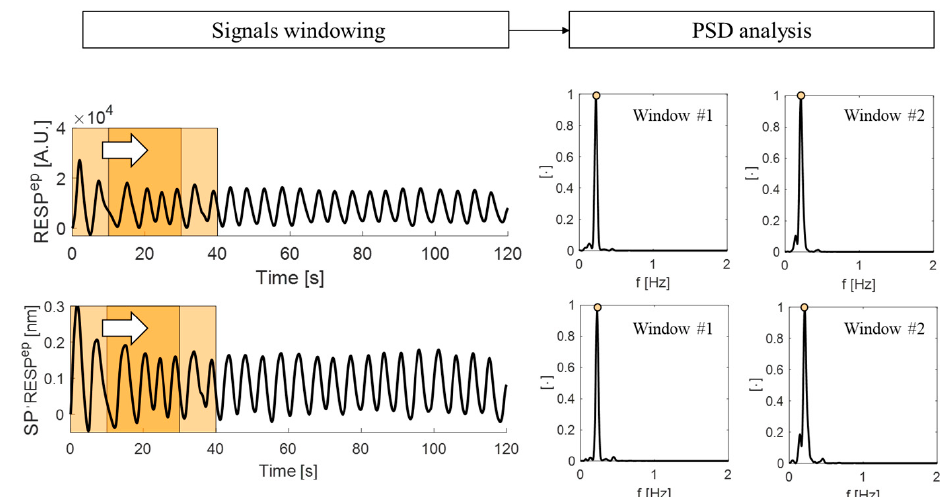
Figure 10. The signals windowing performed over the respiratory signals (reference trace RESP ep and SP RESP ep ) recorded during eupnea in supine position. Two consecutive 30 s windows with an overlap of 10 s are highlighted (orange squares). For each window, the PSD spectrum is computed. Therefore, the RR and HR values estimated by the smart patch and the reference system were obtained from the PSD dominant frequency and expressed in apm and bpm, respectively. The windowed values of RR and HR of a subject (i.e., S1) in the three assumed positions during eupnea and tachypnea are shown in Figure